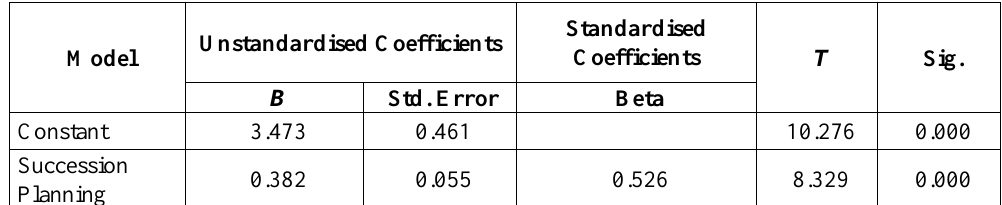
Table 4. Regression results